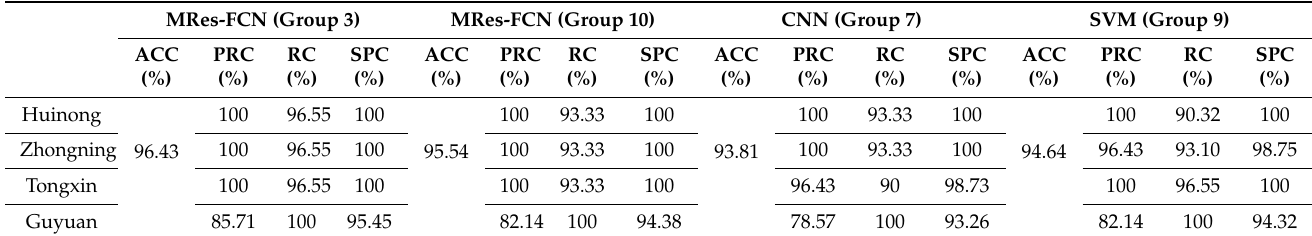
Table 2. Model evaluation indexes of different producing